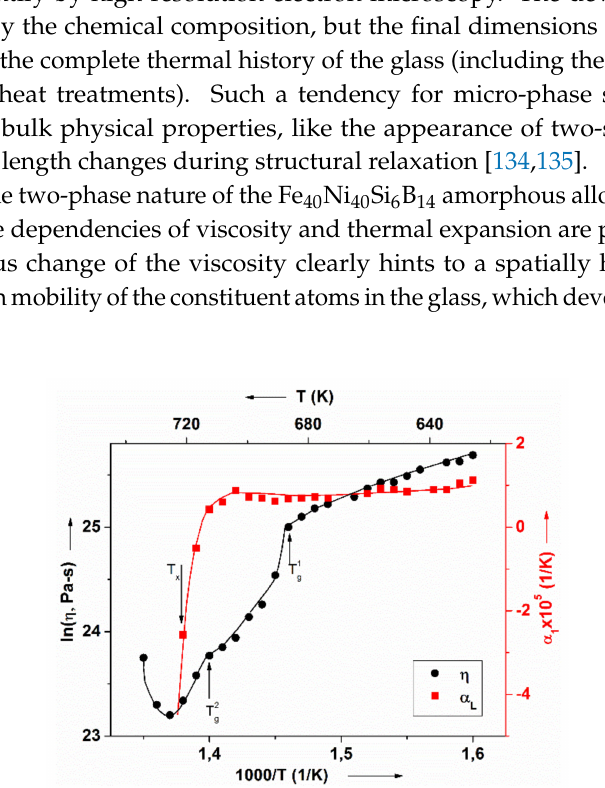
Figure 42. Temperature dependence of the viscosity ( η ) and the thermal expansion coe ffi cient ( α ) of the Fe 40 Ni 40 Si 6 B 14 amorphous alloy. Adopted from [136], with permission from Elsevier,